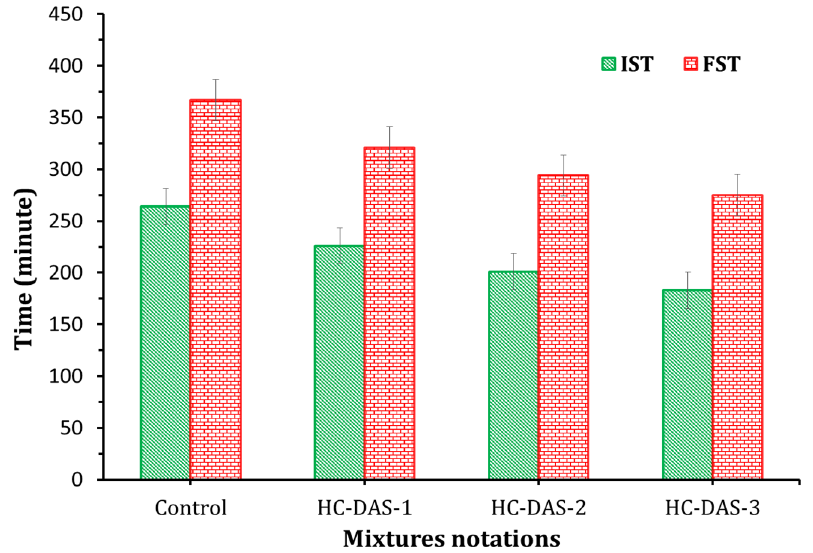
Figure 5. Setting time of the fresh BFS-OPC and one-part HC pastes.